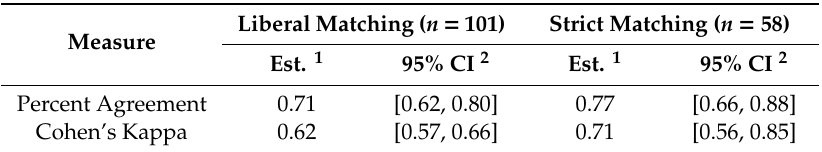
Table 4. Accuracy of the algorithm to classify correctly the type of outlet in the administrative dataset, by outlet matching